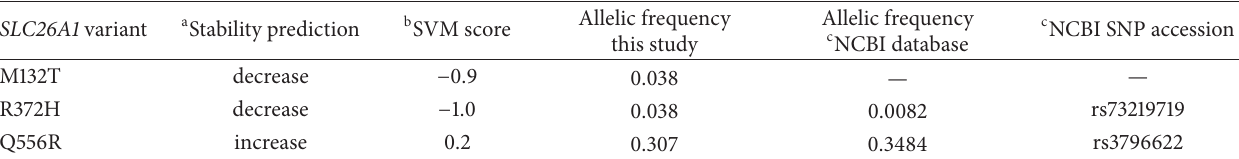
Table 3: Predicted effect of missense gene variants on SAT1 protein structure stability, and allelic frequencies of these variants in the NCBI SNP database.